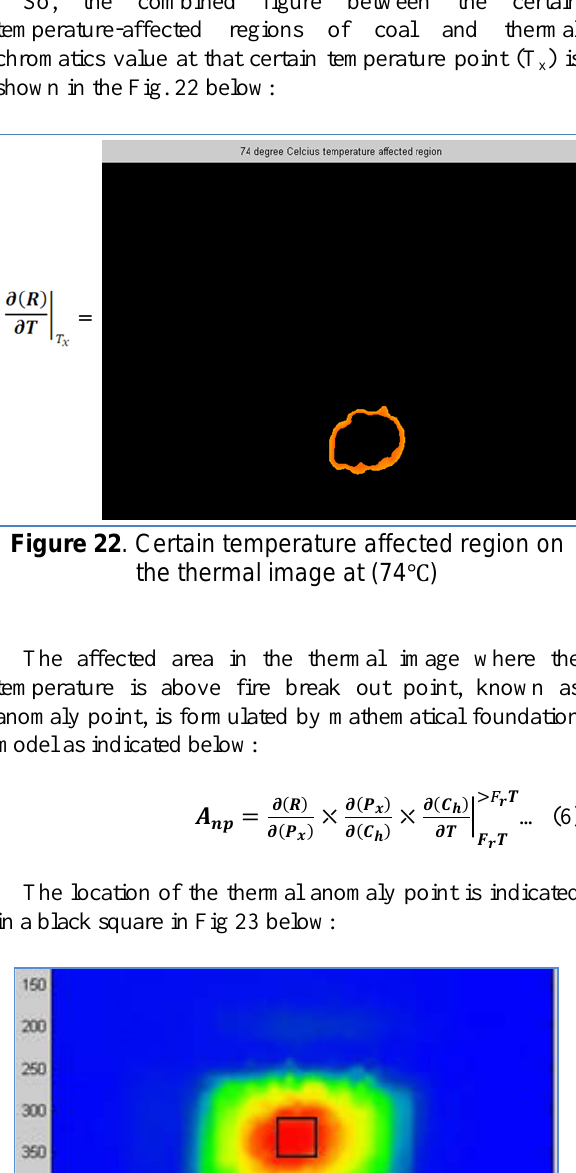
combustion ignition point-lines are taken as the graph plotting technique as described in the fig 26